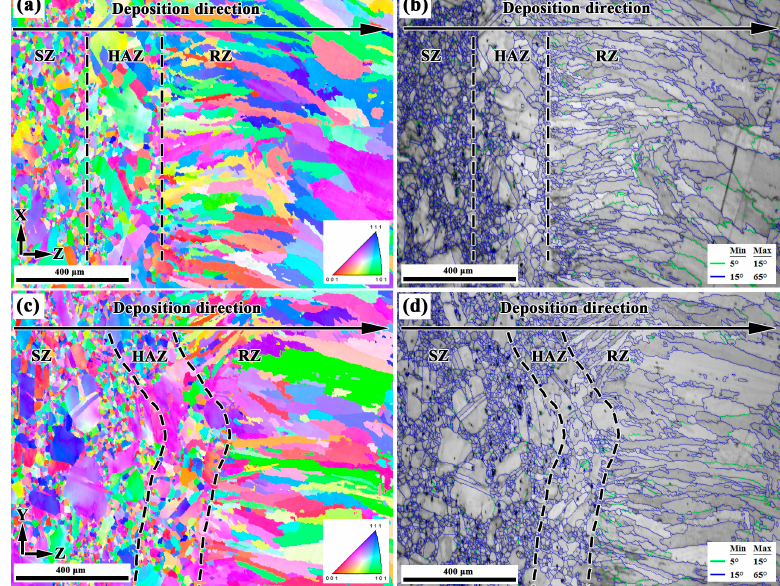
Figure 5. EBSD results of the LARed Inconel 625 samples around the repaired interface in the ( a )( b ) X–Z section, and ( c )( d ) Y–Z section: ( a )( c ) inverse pole figure (IPF) orientation maps, and ( b )( d ) band X–Z section, and ( c , d ) Y–Z section: ( a , c ) inverse pole figure (IPF) orientation maps, and ( b , d ) band contrast maps. contrast